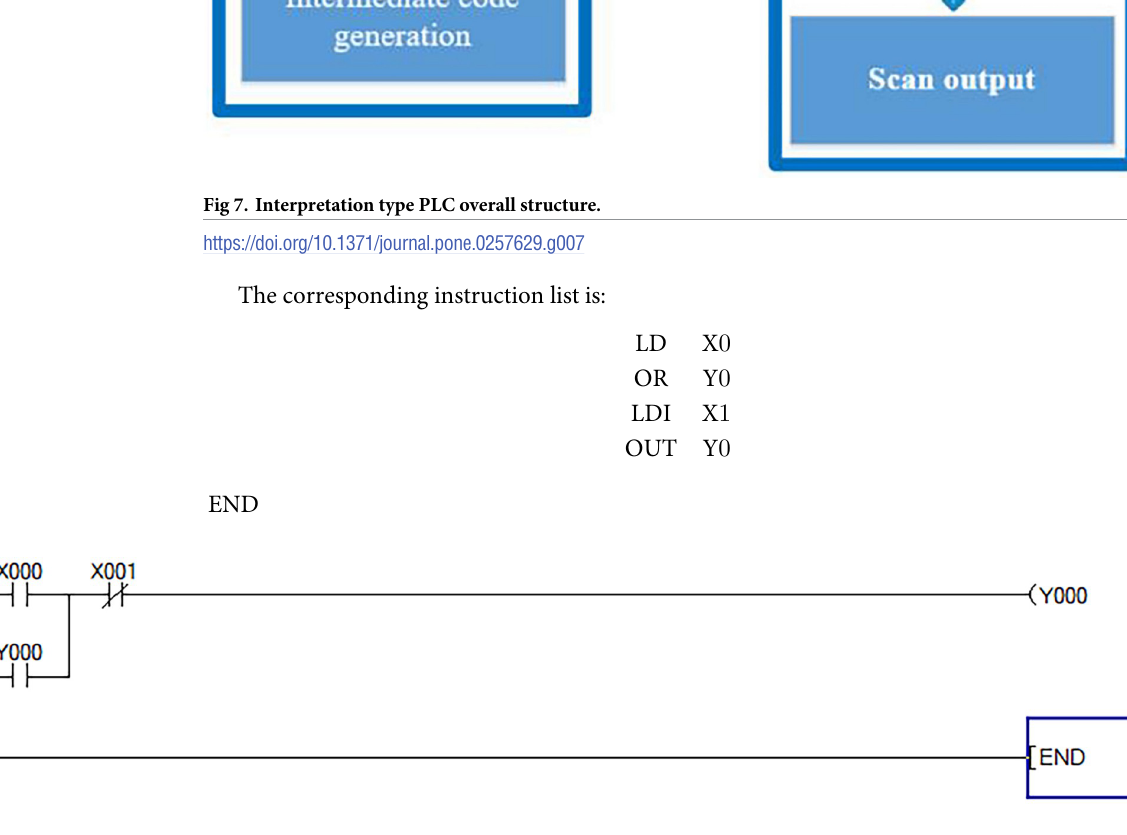
Fig 8. Schematic diagram of PLC ladder